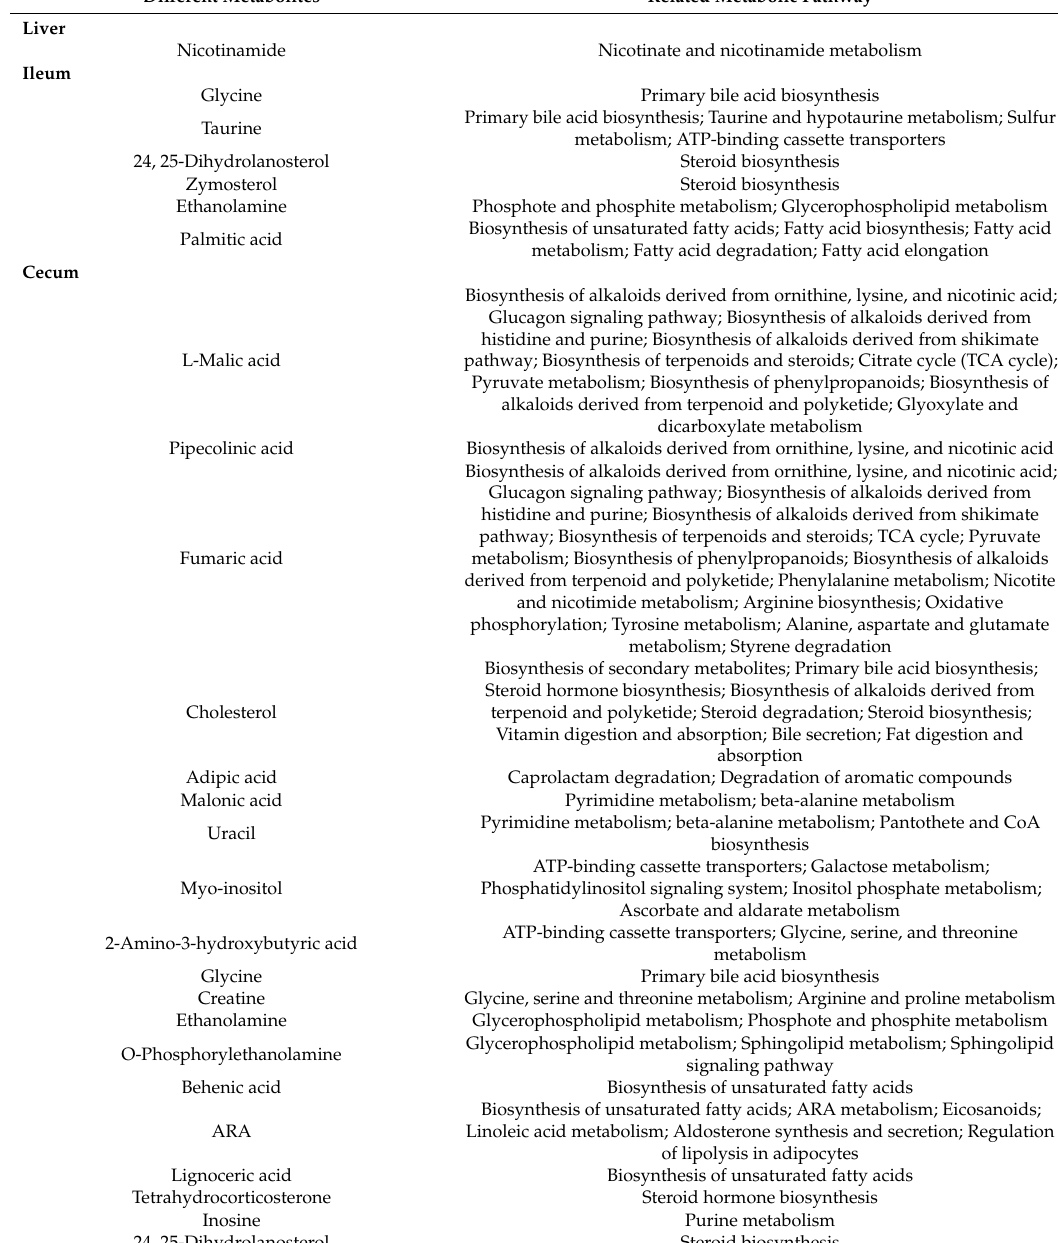
Table 4. Metabolic pathways identified with the di ff erent metabolites in the liver and intestinal contents between the control and overfed geese on the 24th day of